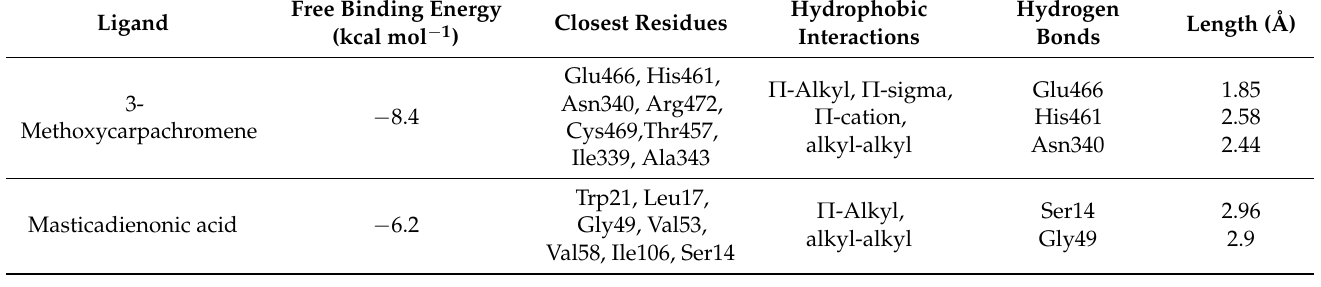
Table 3. The results of interactions between compounds and trypanothione reductase.